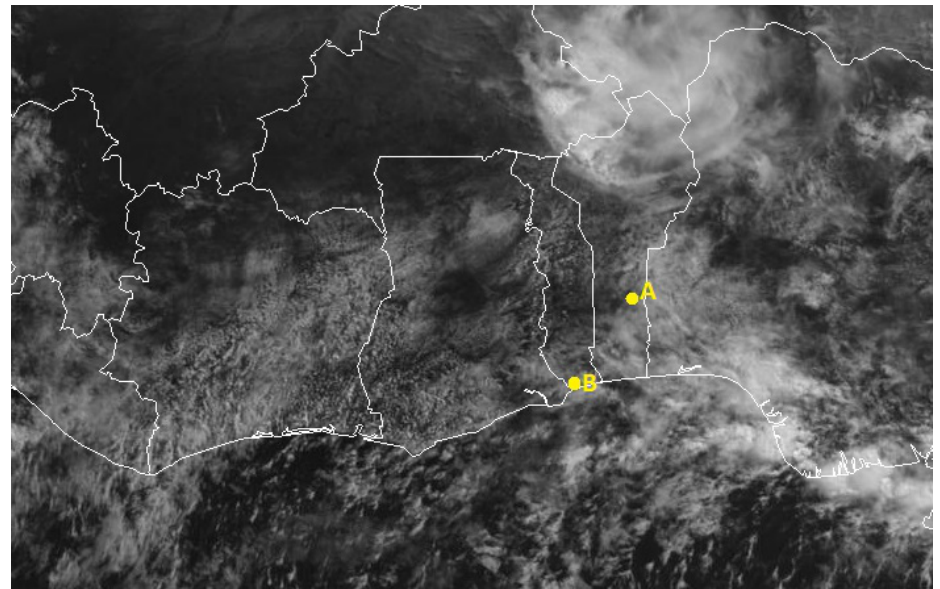
Figure 1. Image from the 0.6µ visible channel of the Meteosat-10 geostationary satellite, revealing the cloud structure over southern West Africa at 10:12UTC on 5 July 2016. Borders and coastlines are highlighted, along with the locations of Savé and Lomé, labelled “A” and “B” respectively. Image obtained from http://catalogue.ceda.ac.uk/uuid/5fa2529b973e47ae38ab3557f2018ef4 (link valid as of July